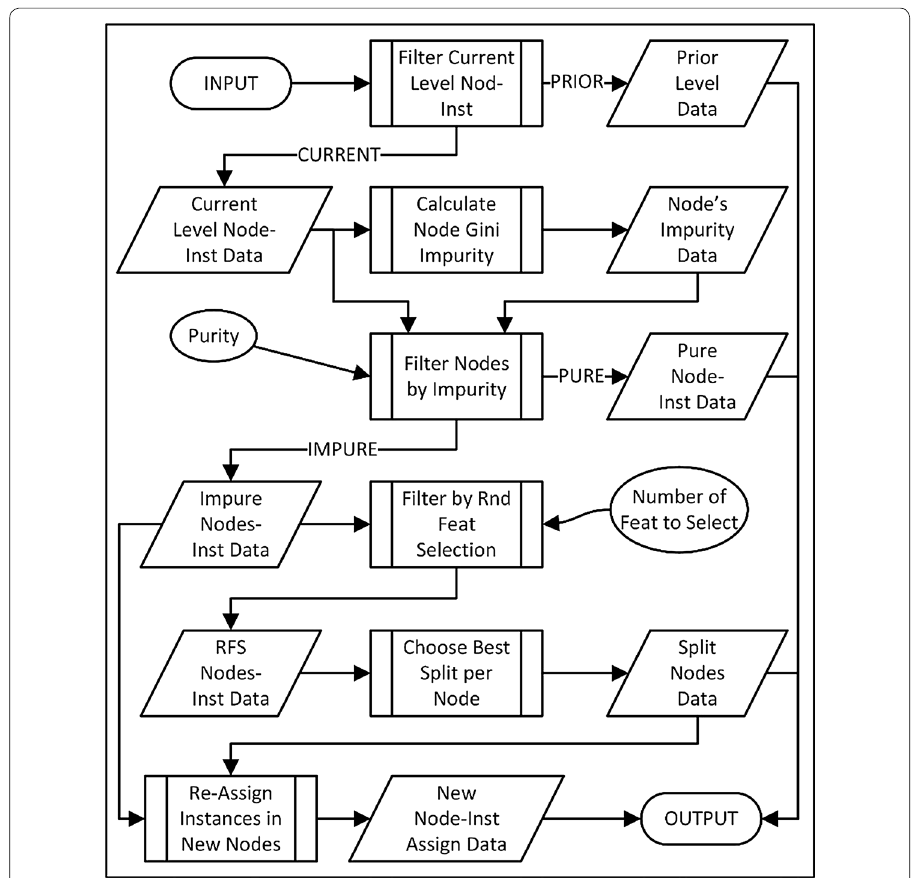
Fig. 6 Random Forest split/partition function